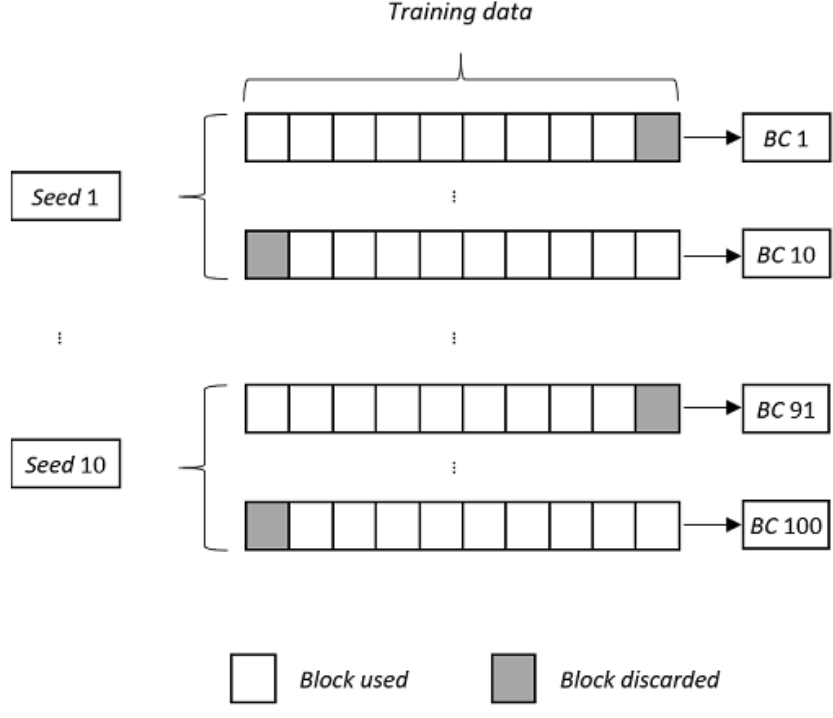
Figure 3. Leave-one-out strategy using ten seeds for generating 100 training datasets to train base classifiers (BC). classifiers